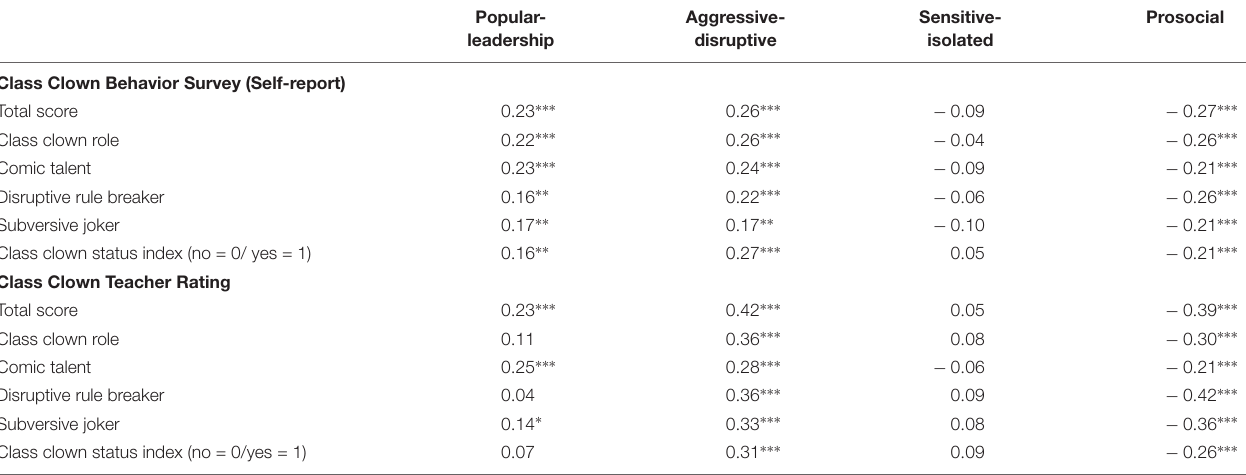
TABLE 4 | Results of multilevel models predicting dimensions of classroom behavior, as assessed by the revised class play (controlled for age and sex): Standardized coefficients for the fixed effects of the predictors (Class Clown Behavior Survey and Class Clown Teacher Rating) of the respective random-intercept models for each predictor entered